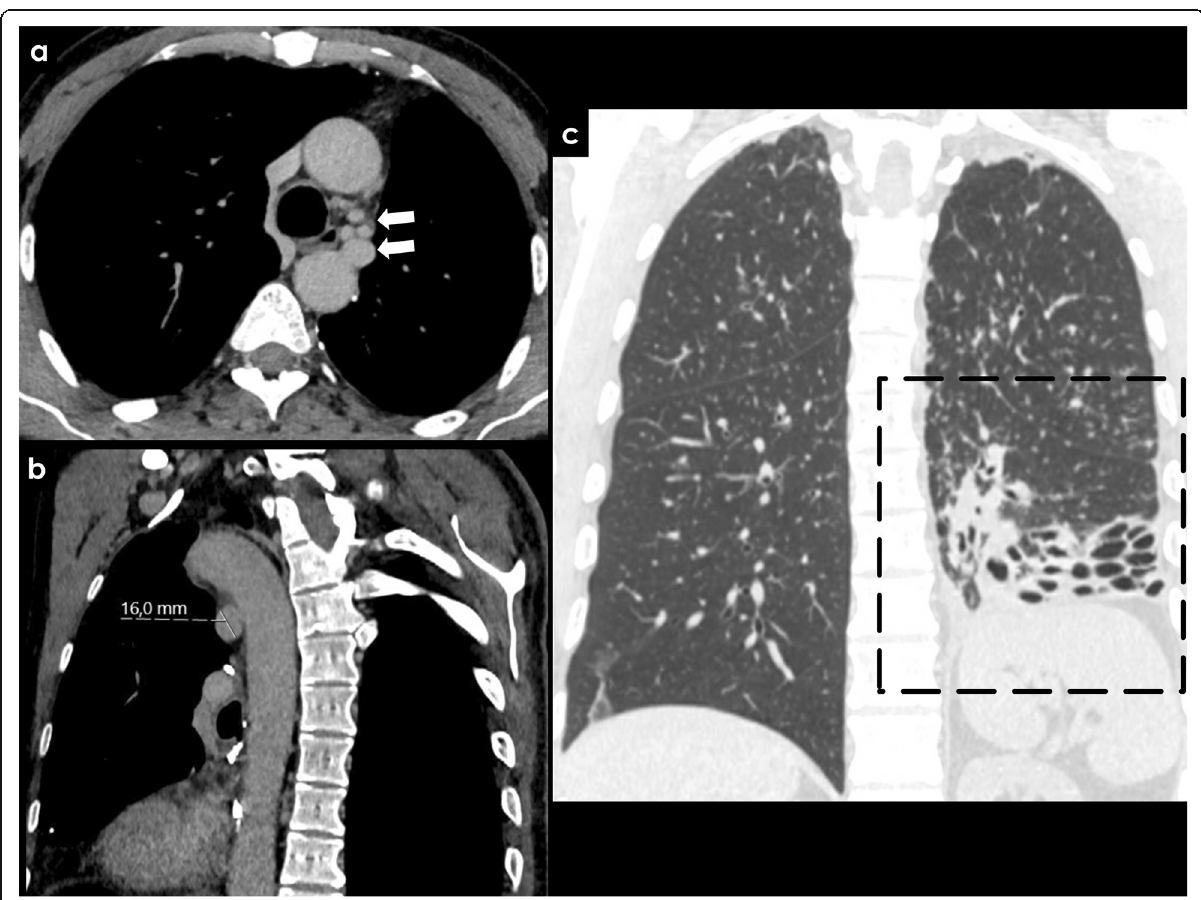
Fig. 6 Acquired causes of BAH — bronchiectasis. Patient with a massive left bronchial artery dilatation ( a , white arrows) reaching 16 mm of caliber ( b ), related to the long-term history of bronchiectasis in the left lower lobe ( c